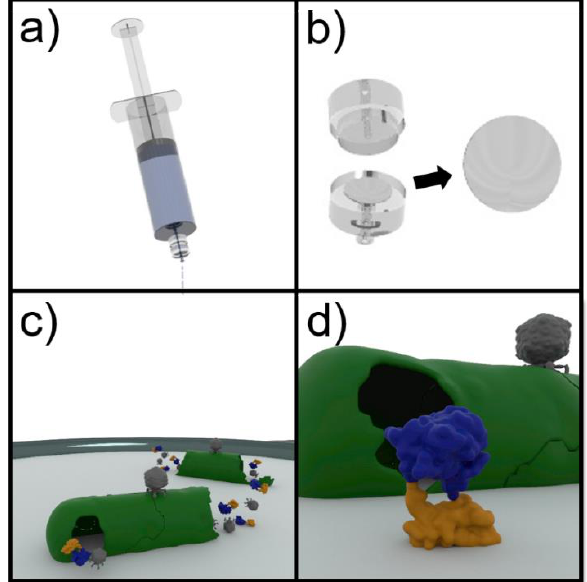
Figure 1. Assay format for the detection of E. coli in drinking water. ( a ) The water is filtered through a 0.22 µm cellulose filter in order to separate the bacteria. ( b ) The filter is then removed from the housing and placed on LB media in order to resuscitate the trapped bacteria. ( c ) Following the application of the engineered phages (grey), an infection cycle results in the expression and release of a reporter enzyme consisting of NanoLuc (blue) and a carbohydrate binding module (orange) with specificity to cellulose. ( d ) The fusion enzyme binds to the cellulose filter and the luminescent activity can then be determined.